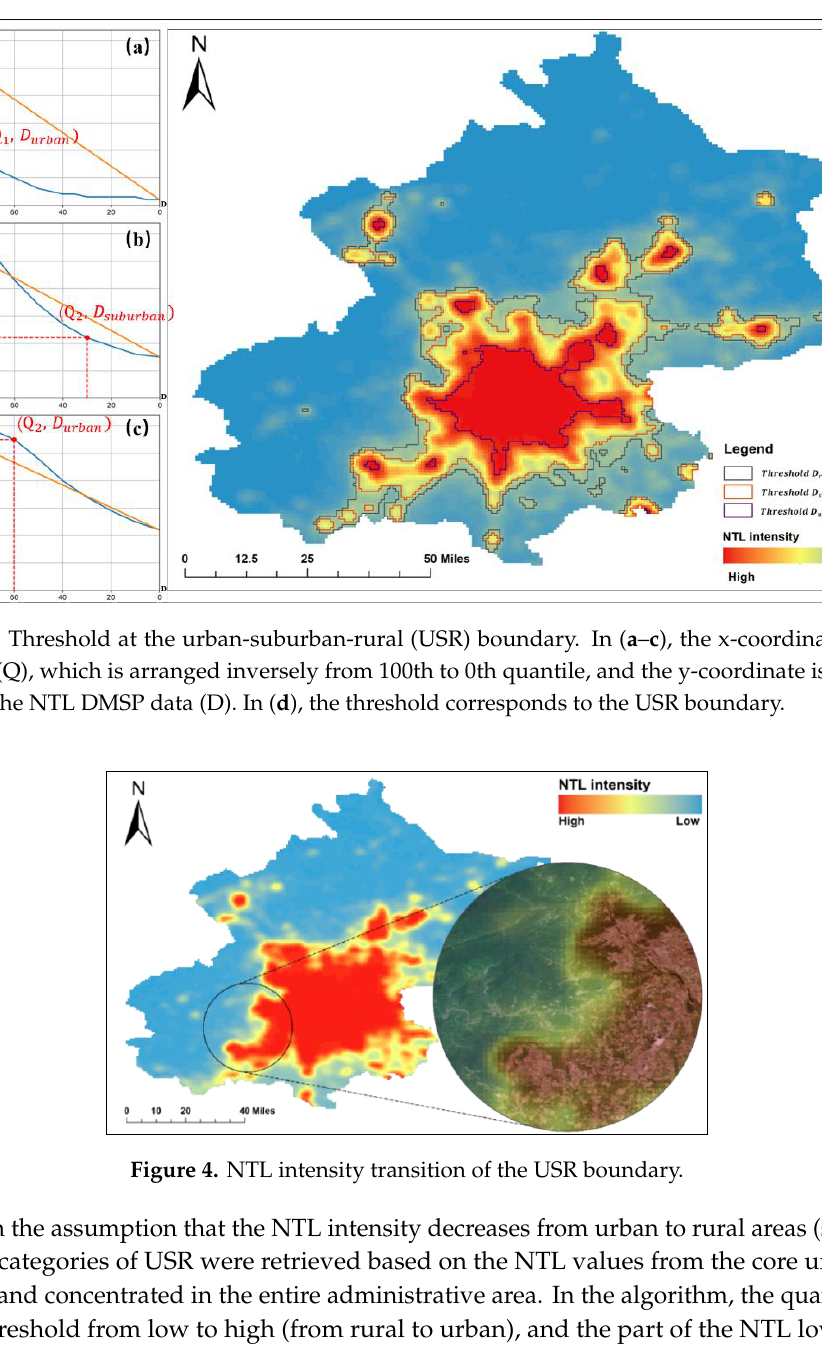
Figure 4. NTL intensity transition of the USR boundary.